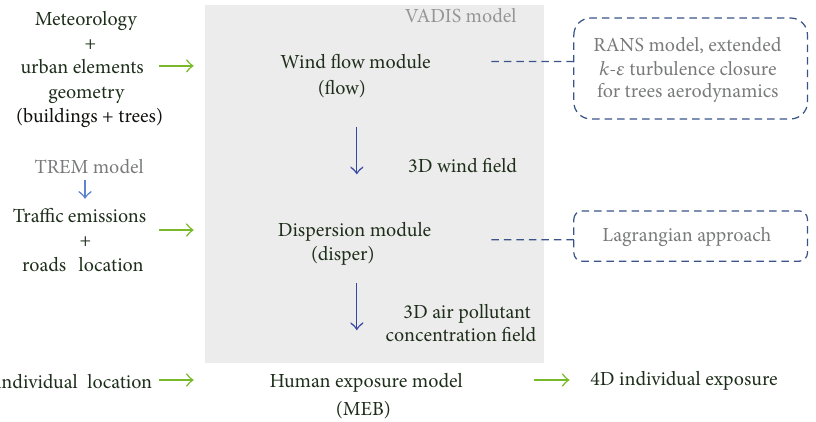
Figure 1: Schematic representation of modeling system